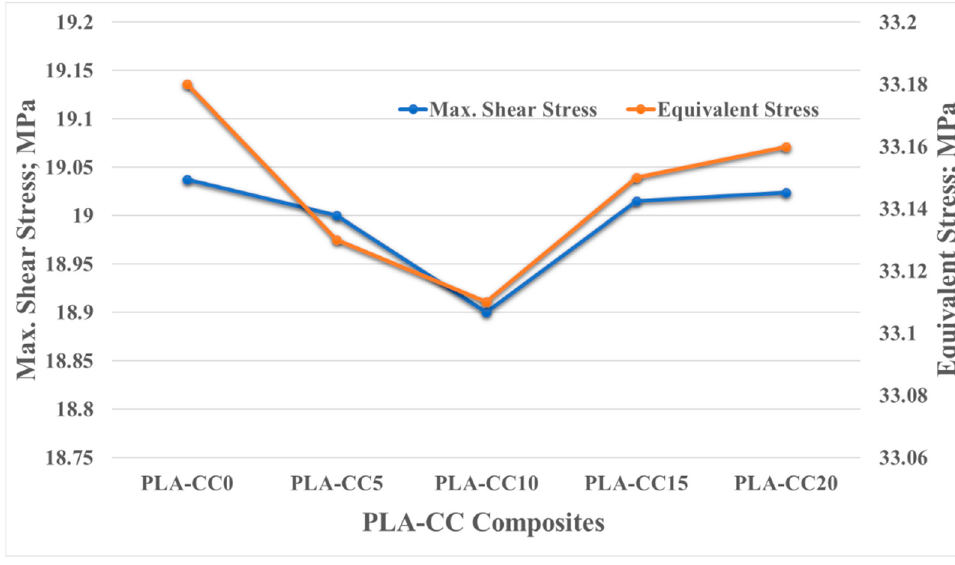
Figure 13. The equivalent and maximum shear stresses on the surface of the articulator liner.